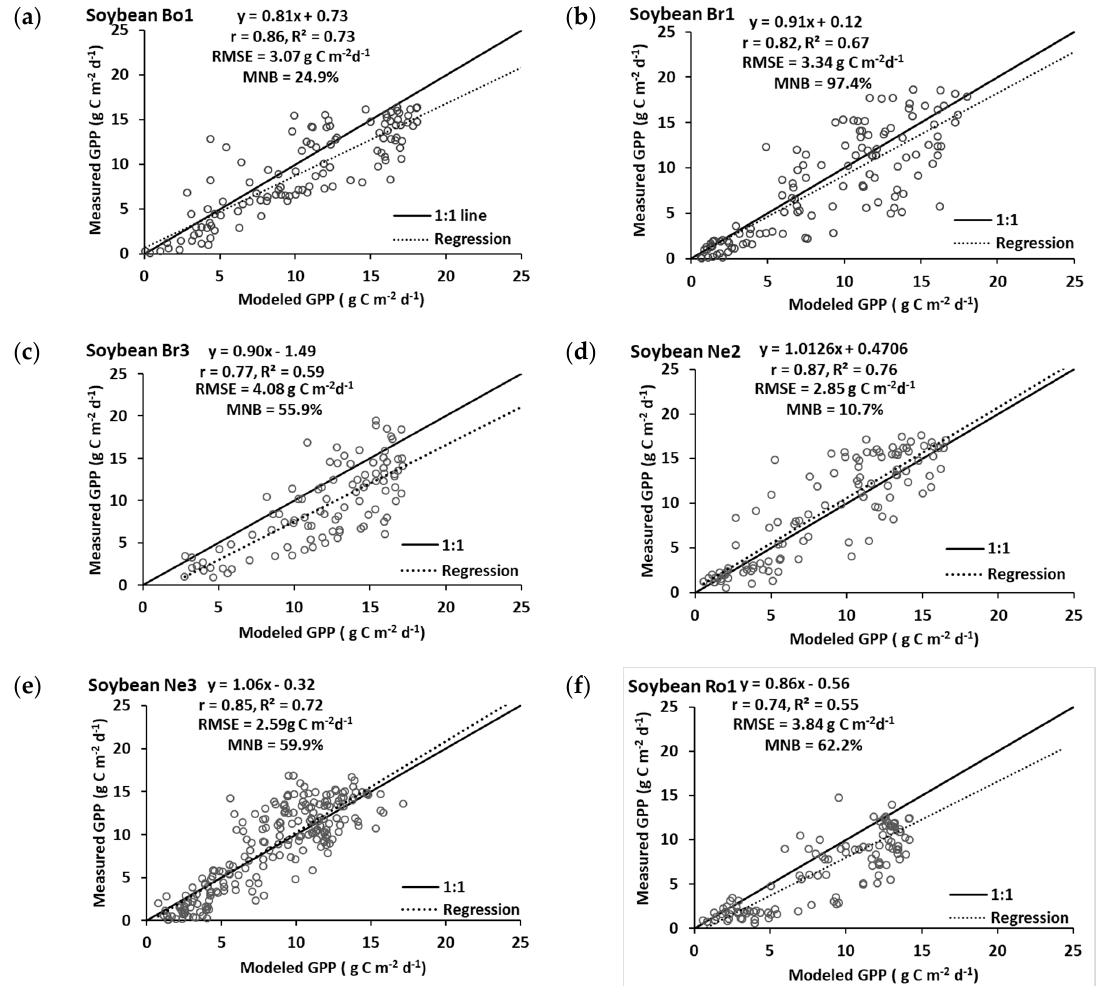
Figure 6. Measured AmeriFlux vs. LUEc modeled daily GPP for all soybean validation years by site: ( a ) US-Bo1; (b) US-Br1; ( c ) US-Br3; ( d ) US-Ne2; ( e ) US-Ne3; and ( f ) US-Ro1.